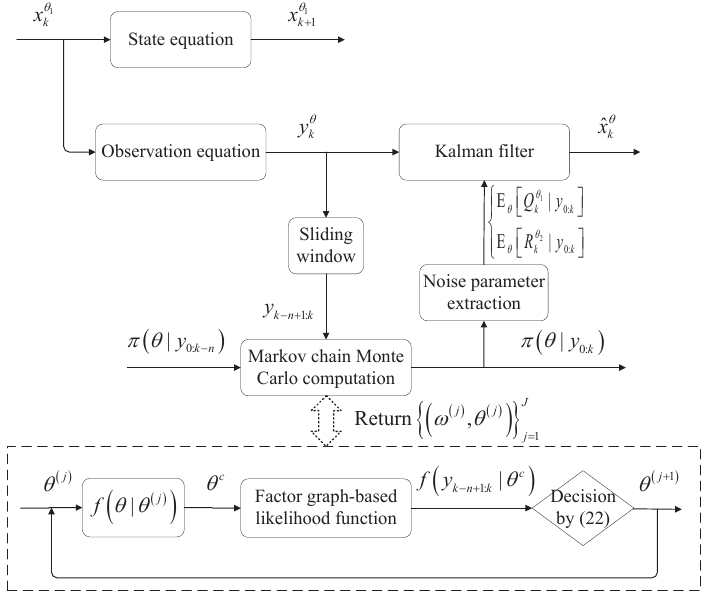
Figure 2. The schematic representation of the proposed